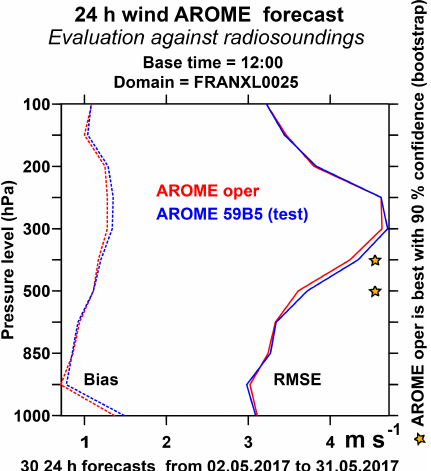
Figure 5. Scores (bias and RMSE or EQM) of 24h range wind forecast with respect to radiosoundings on FRANXL0025 area. The stars show the levels where the distance between the red and blue curves is statistically significant.